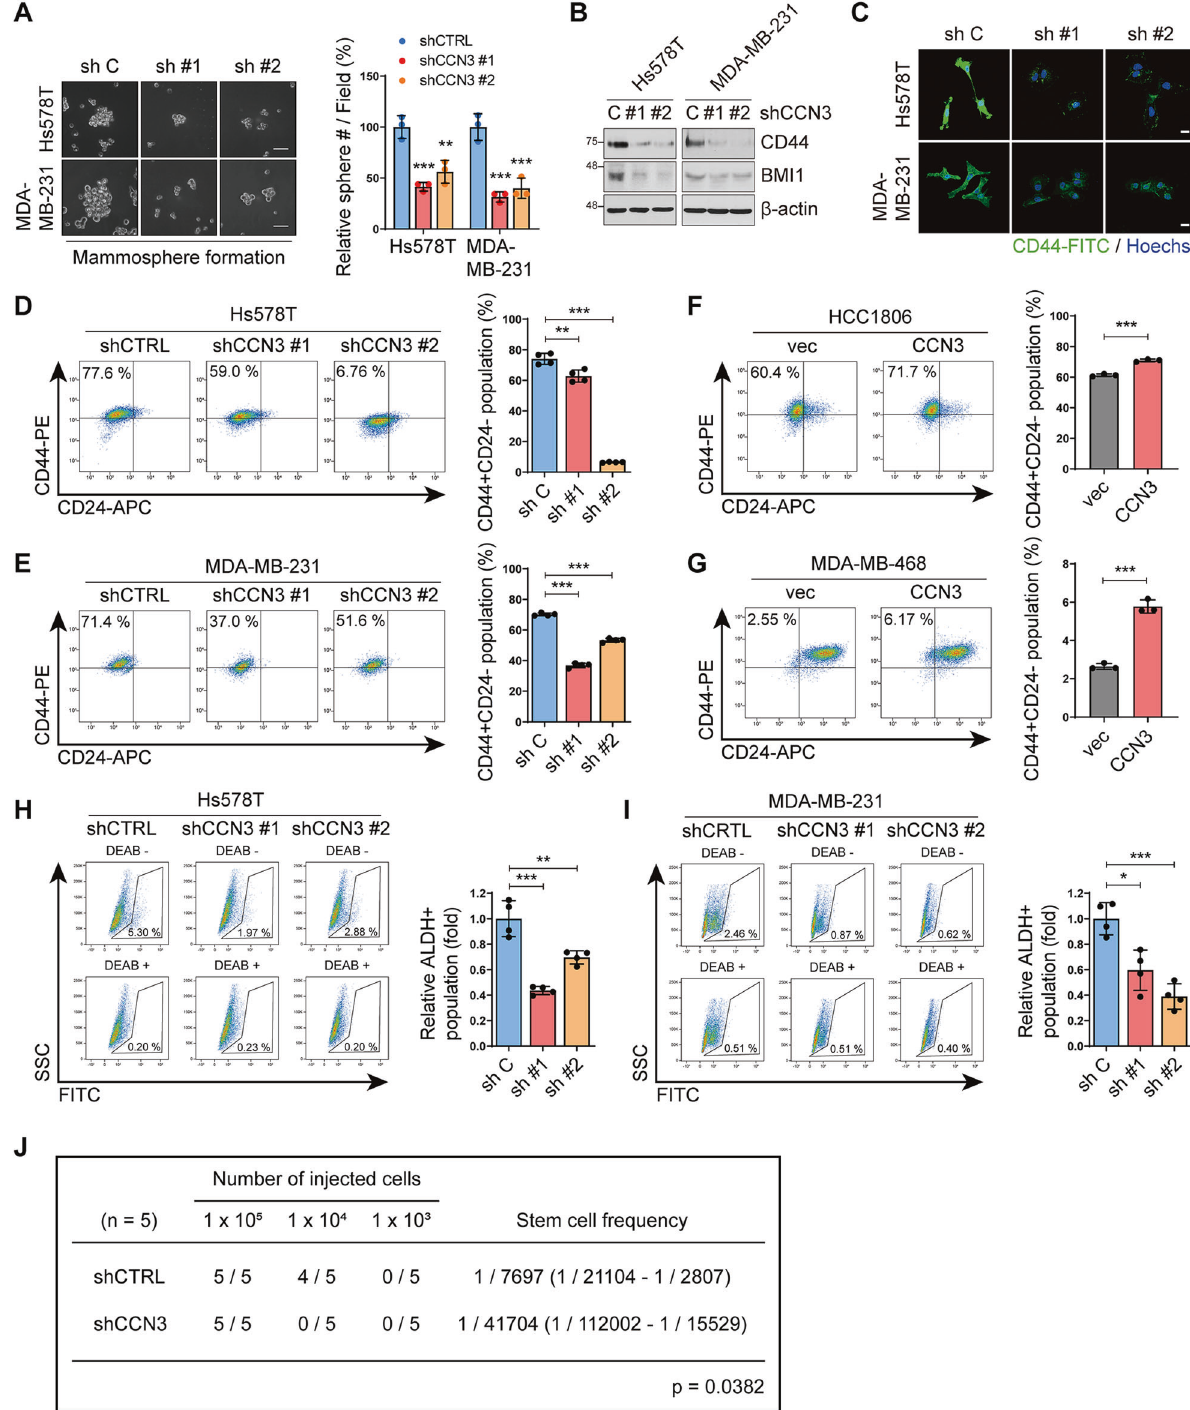
knockdown (Fig. 8H, I and Fig. S14A). The activation of the EGFR/ERK pathway regulated by GPNMB was also reduced (Fig. S14B). Moreover, we con fi rmed that Wnt pathway activation by LiCl, an inhibitor of glycogen synthase kinase 3 (GSK3) that forms the β -catenin destruction complex, caused an increase in GPNMB expression at the mRNA and protein levels (Fig. S15). Collectively, these data imply that CCN3 enhances GPNMB transcription via the Wnt/ β -catenin/MITF signaling axis, thereby activating EGFR signaling in TNBC (Fig.